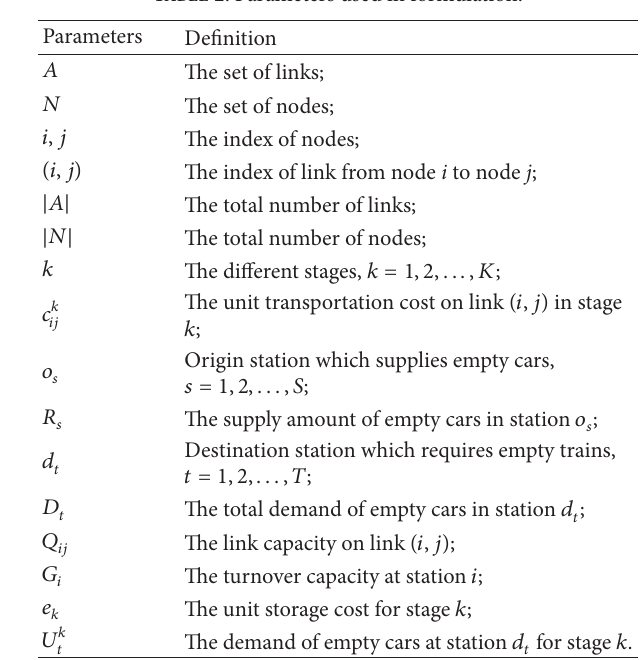
Table 2: Parameters used in